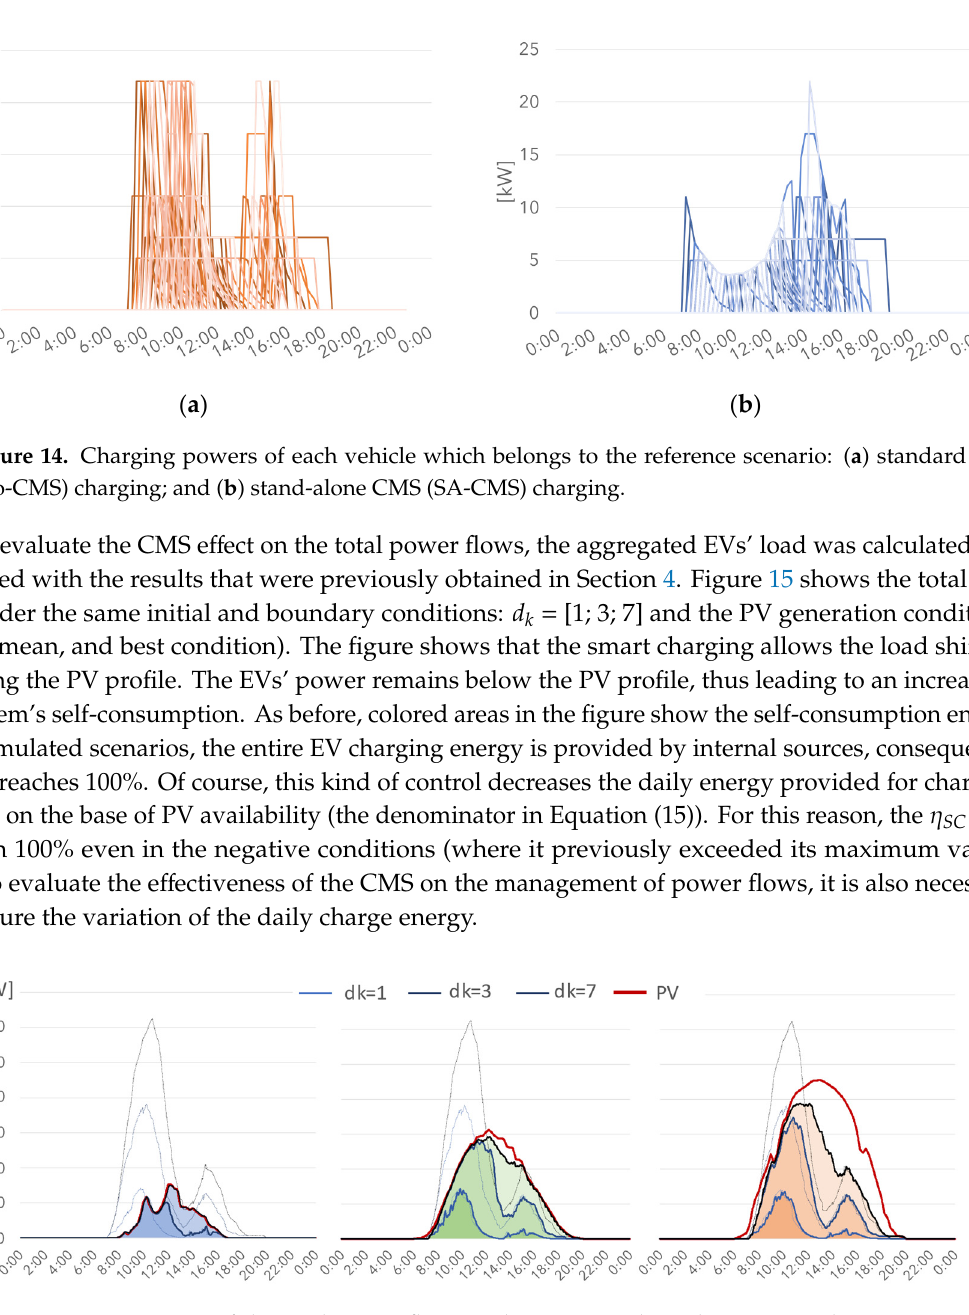
Figure 15. Comparison of the total power flows with SA-CMS. The red curves are the PV power, the blue curves are P EVs with d k = [1;3;7], while the dotted blue curves are the standard (No-CMS) EV load profiles. The colorized areas show the self-consumption energy according to the PV generation conditions: worst condition ( left ), the mean condition ( center ), and the best condition ( right )